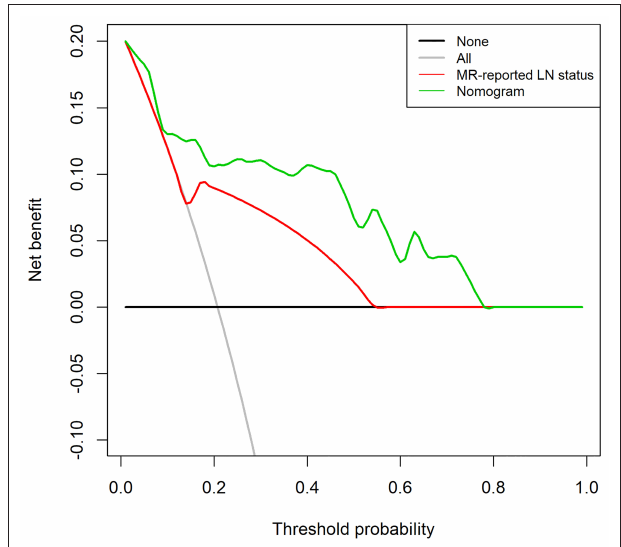
FIGURE 6 | Decision curve analysis (DCA) for the radiomics nomogram and the MRI-reported LN status in the validation set. The y -axis represents the net benefit. The x -axis represents the threshold probability. The decision curves showed that if the threshold probability is over 10%, the application of radiomics nomogram to predict LNM adds more benefit than treating all or none of the patients and MRI-reported LN status.